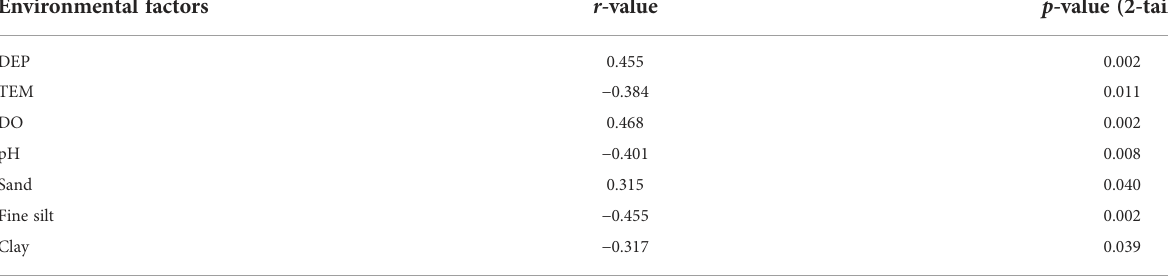
TABLE 4 Pearson correlation between environmental factors and macrobenthos